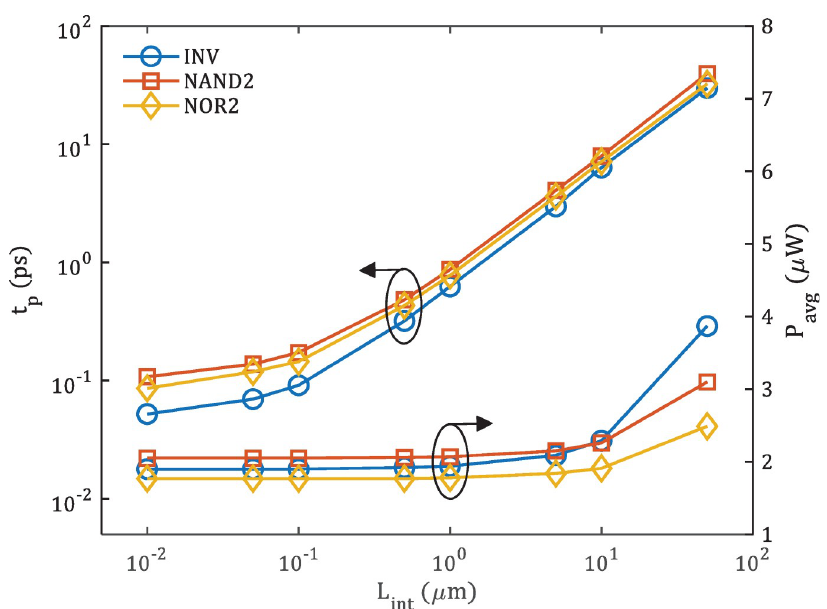
Fig 8. Propagation delay ( t ) and average power ( P ) of silicene-based digital logic circuits with varying p avg interconnect length ( L int ). INV, NAND2 and NOR2 represent inverter, 2-input NAND and 2-input NOR gates, respectively.